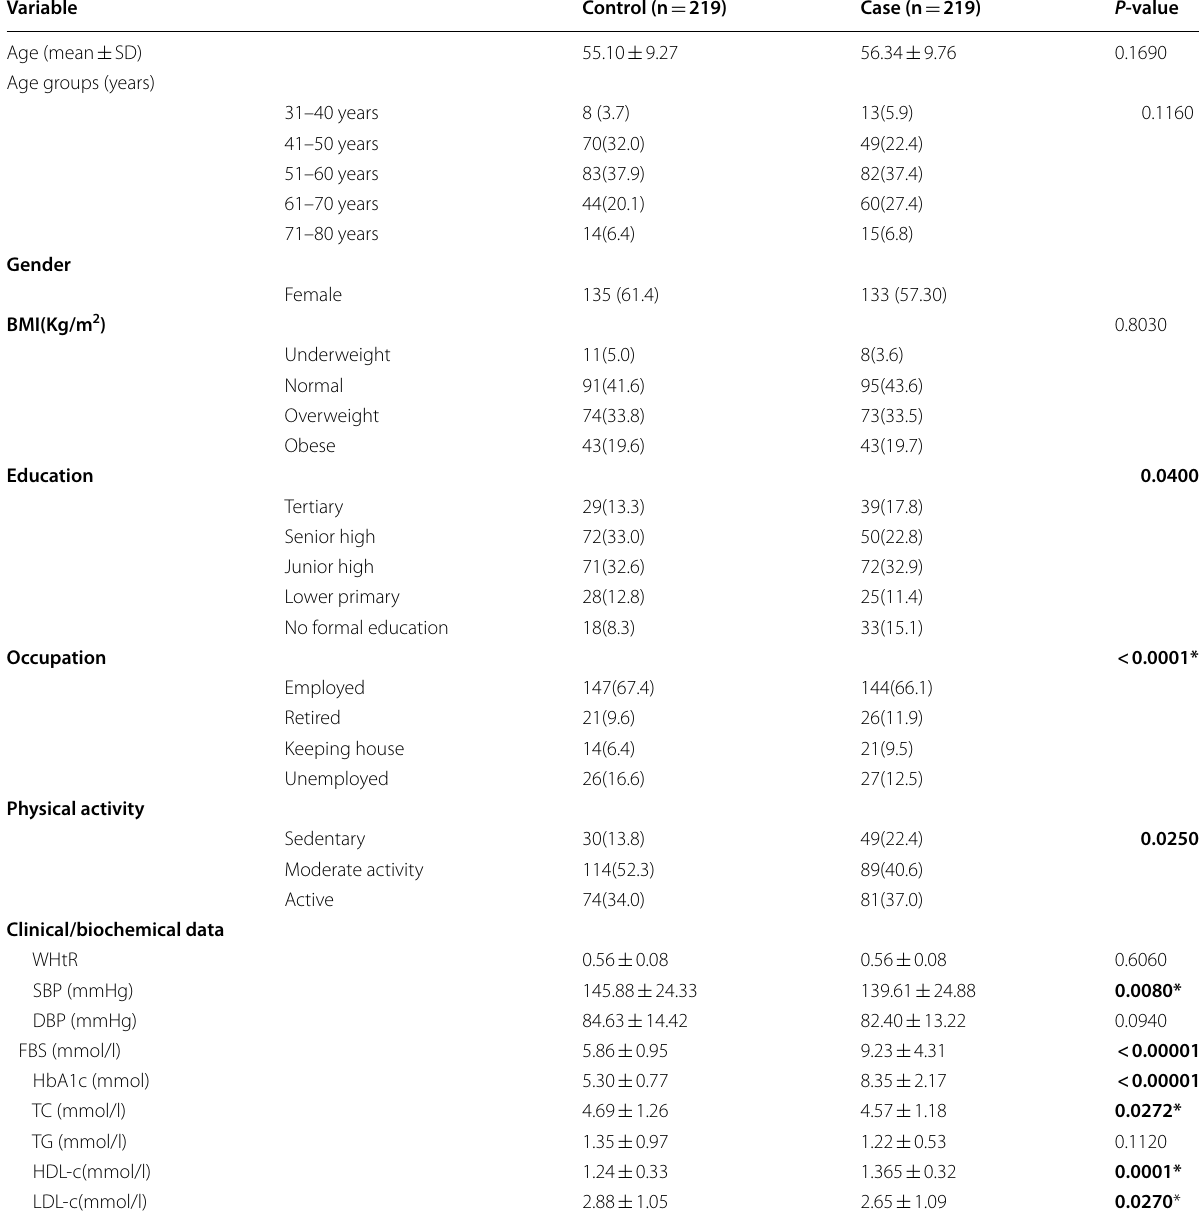
Table 1 Demographic information of T2DM patients and healthy